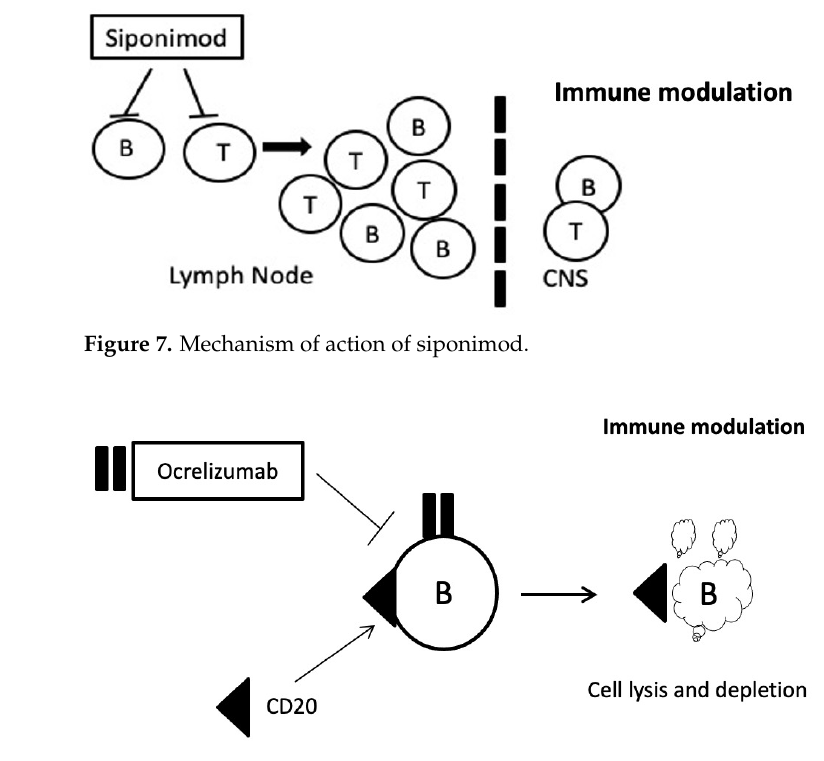
Figure 8. Mechanism of action of ocrelizumab.